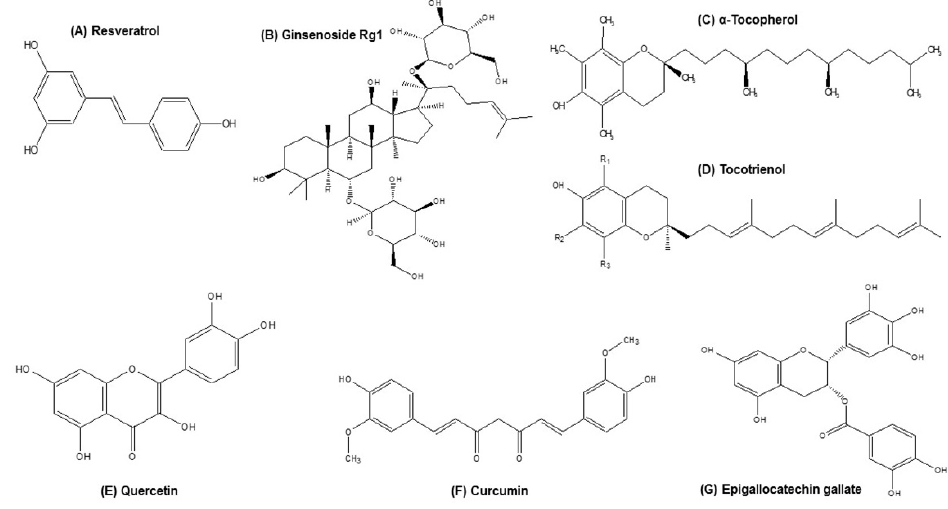
Figure 1. Chemical structures of selected nutrient compounds targeting inflammaging.